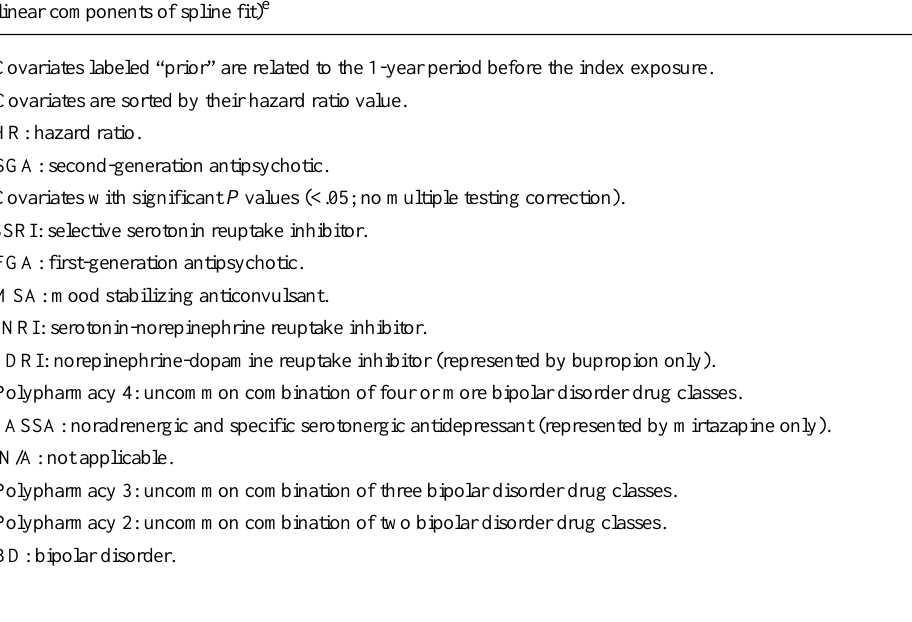
Events (N=8813)Intervals (N=1,749,468)Patients P valueUpper 95%Lower 95%HR b,c Covariates a (N=529,359) N/AN/AN/A1.21×10 -9 N/AN/AN/ANumber of prior unique BD drugs tried (non-